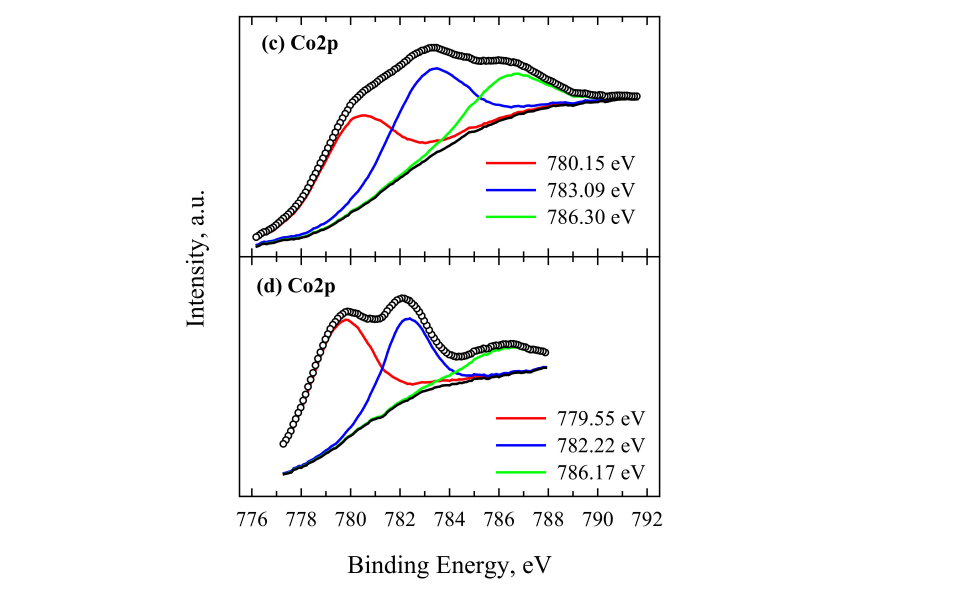
Figure 5. Pd3d XPS spectra for Pd-Cl 2 -Co 3 O 4 /C ( a ) and PdOCo 3 O 4 /C ( b ) catalysts. ( c , d ) Co2p XPS spectra for Pd-Cl 2 -Co 3 O 4 /C and PdOCo 3 O 4 /C, respectively.